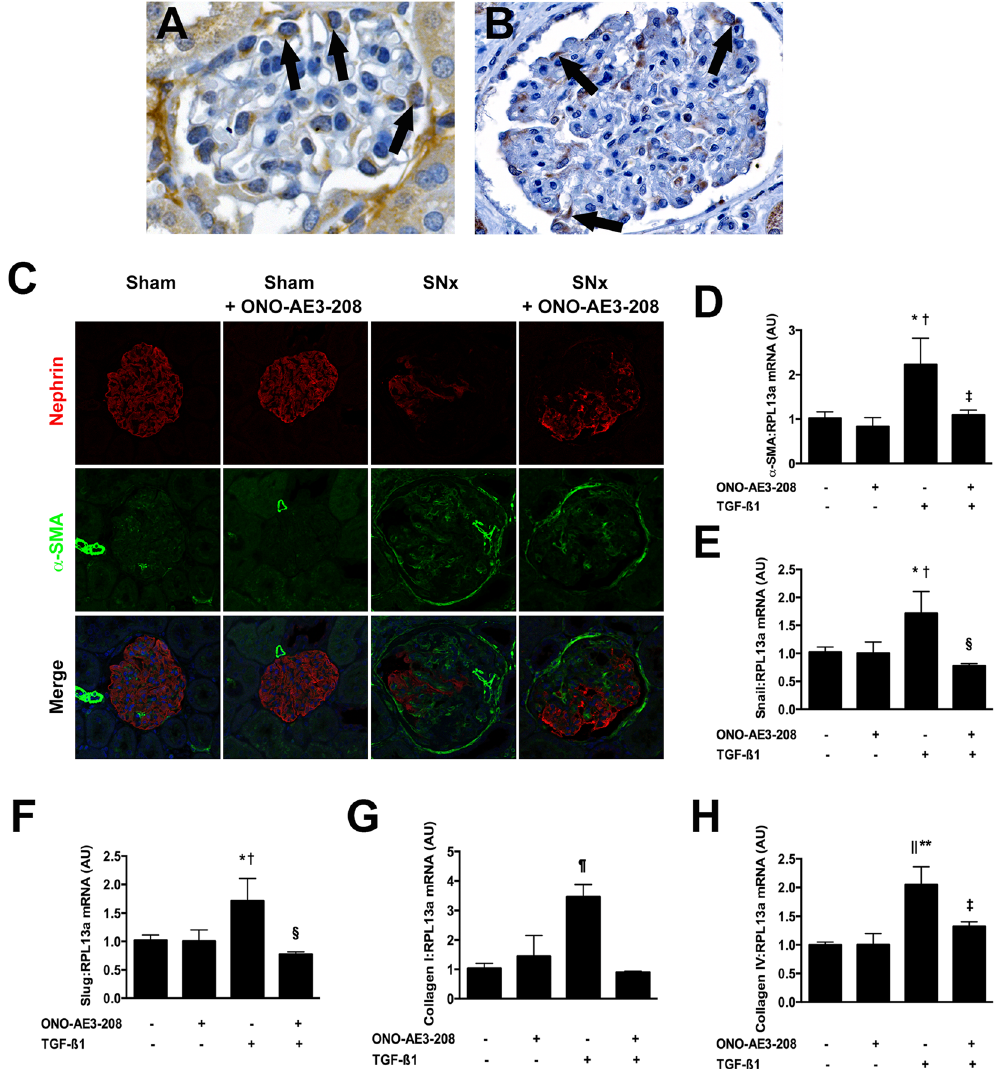
Figure 5. Presence and actions of EP4 in glomerular podocytes. ( A , B ) Immunostaining demonstrating EP4 protein in peripherally arranged glomerular podocytes from ( A ) a C57BL/6 mouse and ( B ) normal human kidney tissue. Original magnification × 400. The arrows mark positively immunostaining peripherally arranged podocytes. ( C ) Dual immunofluorescence for nephrin (red) and α -smooth muscle actin ( α -SMA; green) in glomeruli from sham-operated and subtotally nephrectomized (SNx) rats treated with vehicle or ONO-AE3-208. Blue = DAPI. ( D – H ) Effect of ONO-AE3-208 on TGF-ß1-induced dedifferentiation of cultured mouse podocytes. ( D ) α -SMA mRNA levels. ( E ) Snail mRNA levels. ( F ) Slug mRNA levels. ( G ) Collagen I mRNA levels. ( H ) Collagen IV mRNA levels. AU = arbitrary units. * p < 0.05 vs. control; † p < 0.05 vs. ONO-AE3-208; ‡ p < 0.05 vs. TGF-ß1; § p < 0.01 vs. TGF-ß1; ¶ p < 0.01 vs. all other conditions; || p < 0.01 vs. control; ** p < 0.001 vs.